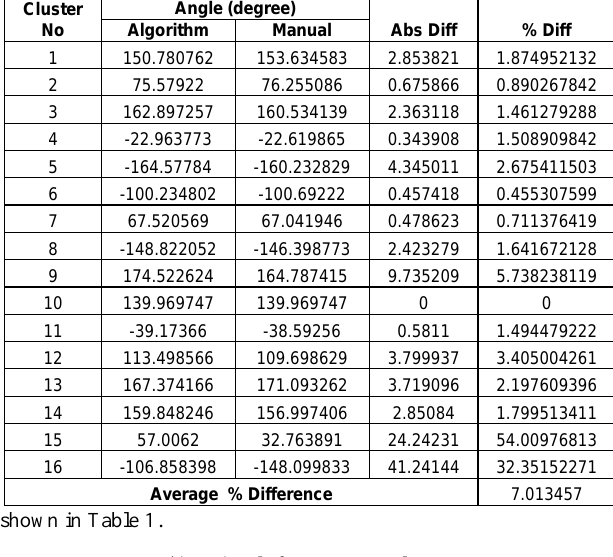
Table 1: Results of Road Segment